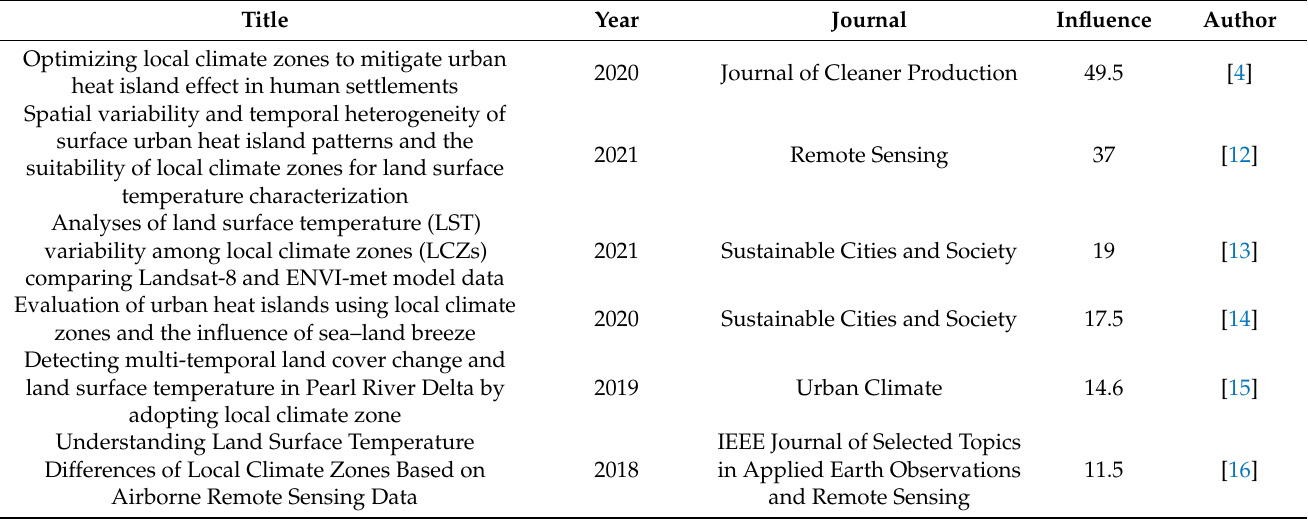
Table 1. Most influential